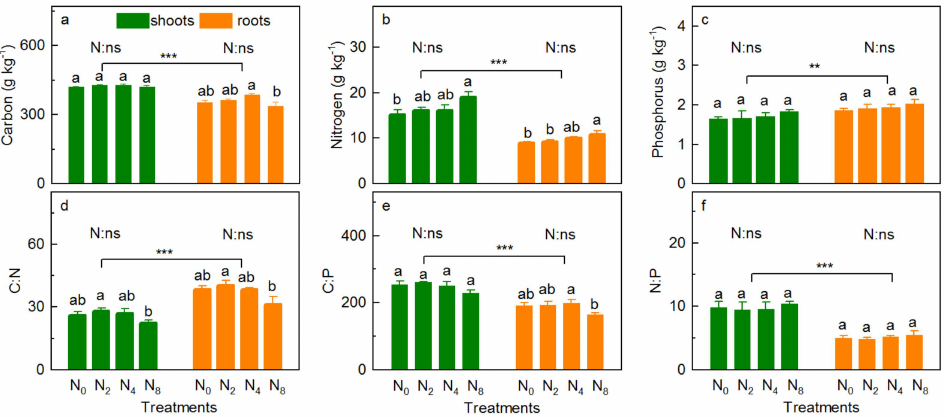
Figure 3. Concentrations of TC ( a ), TN ( b ) and TP ( c ), and C:N ( d ), C:P ( e ) and N:P ( f ) of plant community (shoots and roots) under the N addition rates. p -value of the ANOVA of N addition treatments (0, 20, 40, and 80 kg N ha − 1 y − 1 ) on tissues (shoots and roots) is indicated: ** p ≤ 0.01; *** p ≤ 0.001; ns, not